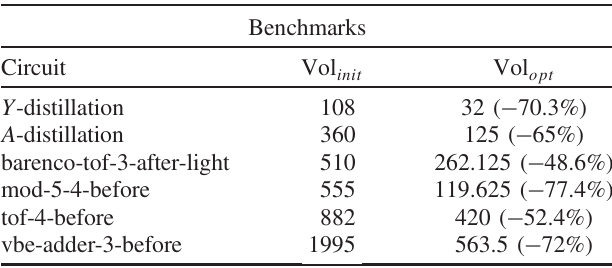
TABLE I. Volumes before and after optimization for a set of circuits from the P y ZX circuit database [36].